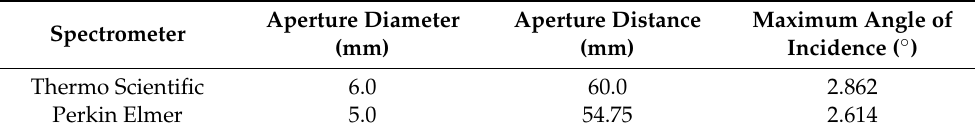
Table 2. AperturesizeandspacingusedforeachFTIRspectrometertoamplifyinterferencefringeamplitude.